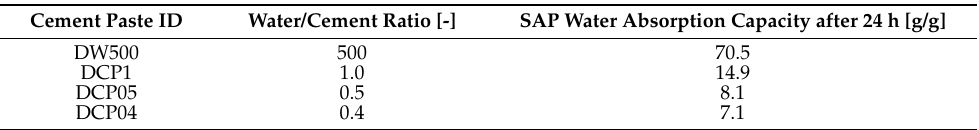
Table 5. The water absorption capacity of SAP B in water absorption environments characterized by different water-to-cement ratios.